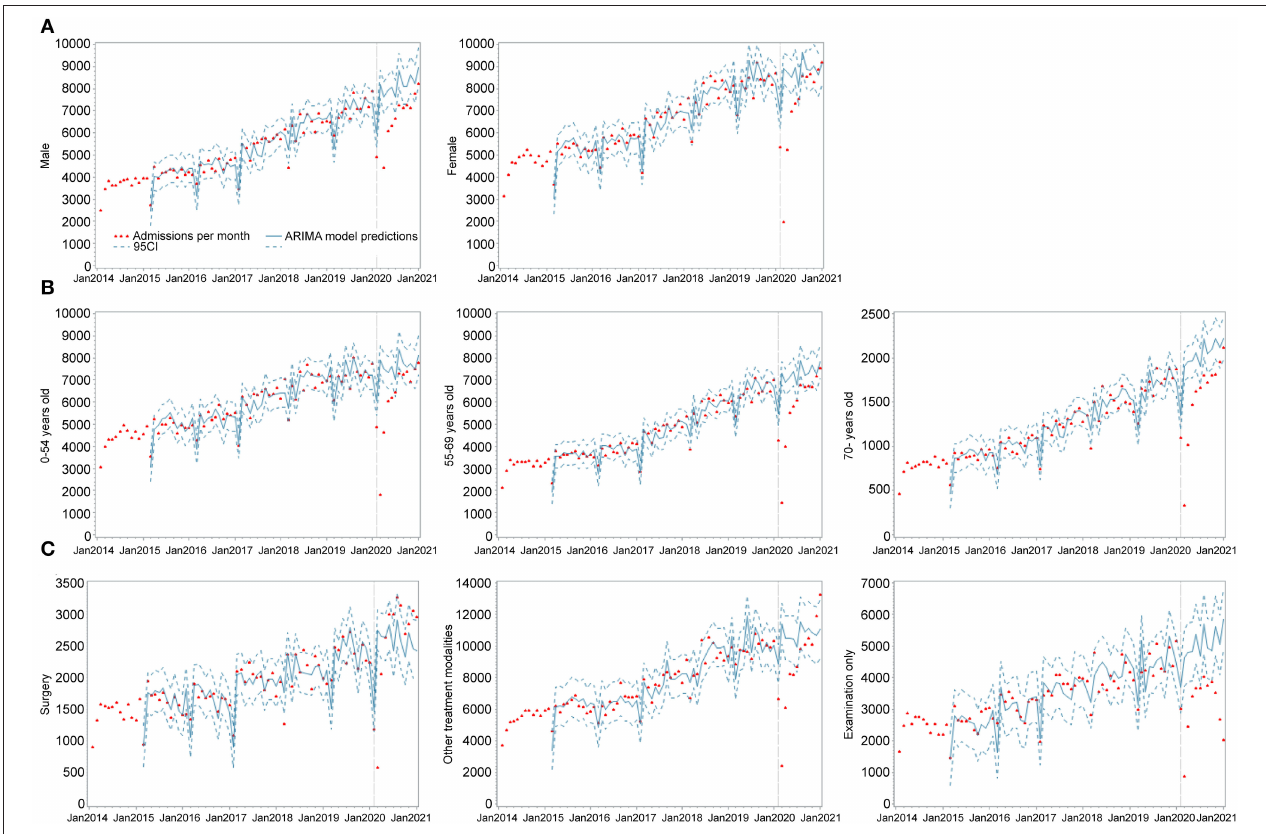
FIGURE 2 | Monthly admissions before and after the COVID-19 lockdown in Henan Cancer Hospital stratified by sex, age group, and treatment modalities. (A) Admissions by sex. (B) Admissions by age group. (C) Admissions by treatment modalities. Vertical lines represent change-point (lockdown). Fitted lines represent ARIMA regression models of the admissions. Surrounding dashed lines represent 95% confidence intervals. increased by 485.0 (95% CI: 216.4–753.4) per month, reaching 90.7% of counterfactual levels (95% CI: 82.9–100.1%) by